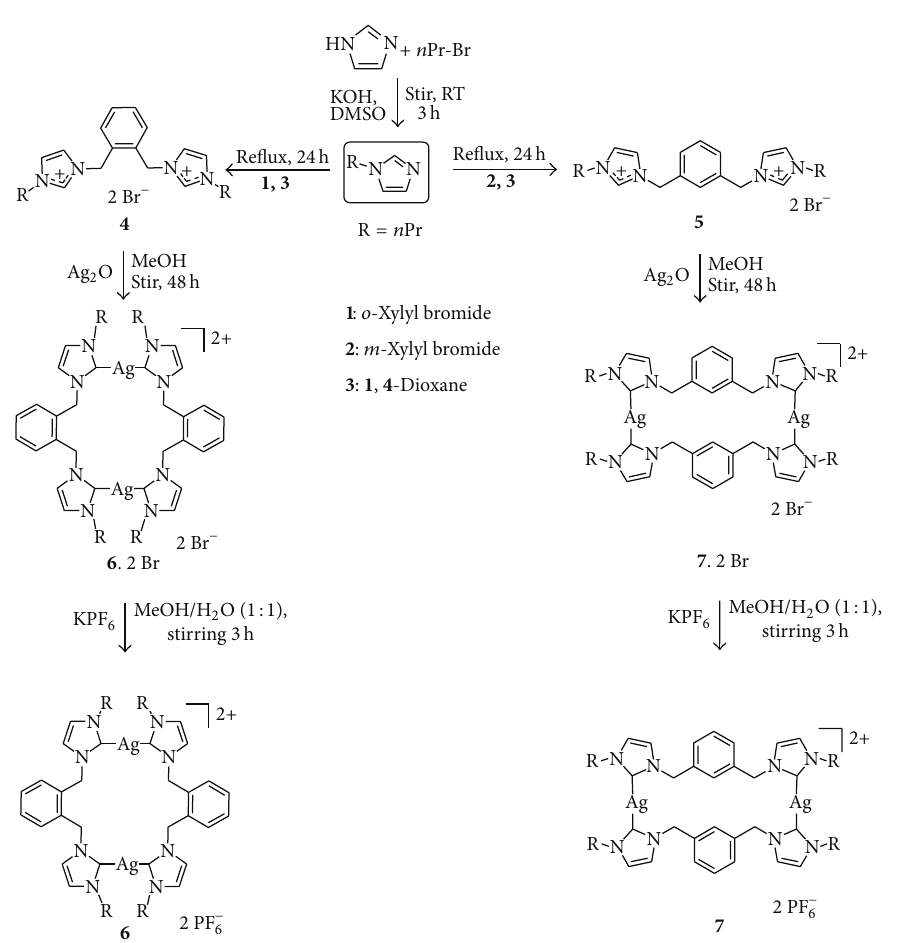
Scheme 1: Synthesis of xylyl linked bis-imidazolium salts ( 4 - 5 ) and respective dinuclear Ag-NHC complexes ( 6 - 7